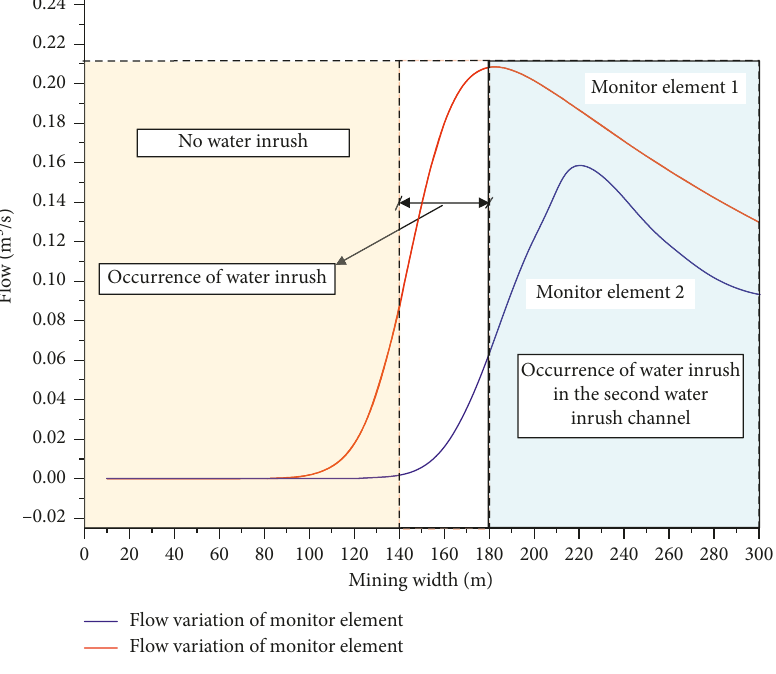
Figure 11: Flow variation of monitor